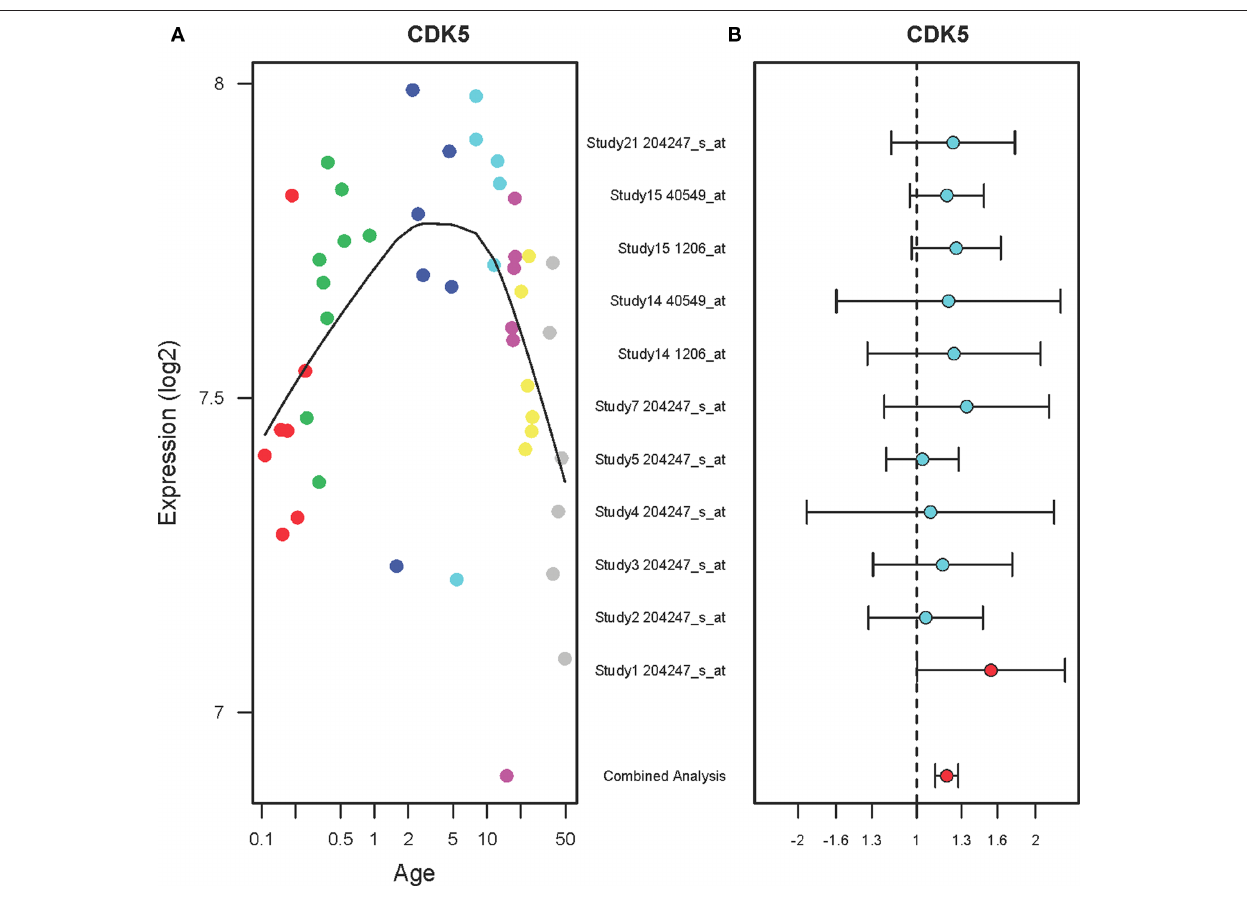
and 95% confidence intervals shows consistent up-regulation of CDK5 in the PFC of suicide victims as compared to the non-suicide controls across nine microarray studies. A combined analysis shown on the bottom represents the weighted fold change and 95% confidence intervals. Individual microarray probes for CDK5 across multiple studies are shown on the left (Study ID and Affymetrix probe ID). Red point: adjusted p < 0.05, Cyan point: adjusted p